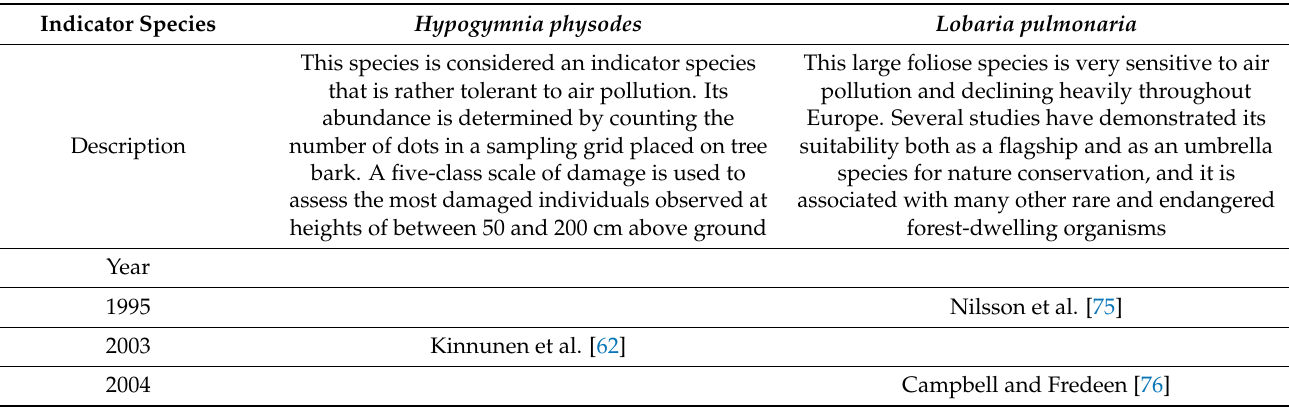
Table 3. Indicator species: list of selected